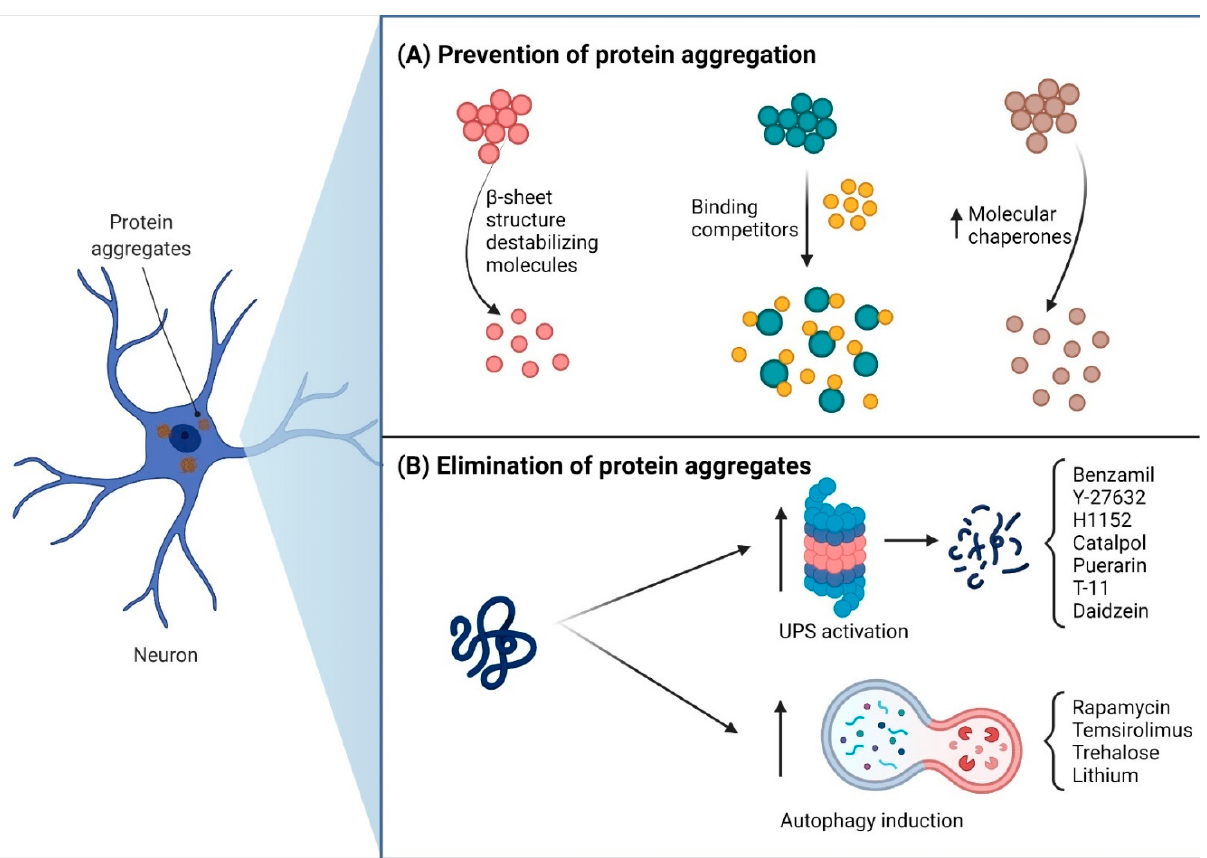
Figure 2. Pharmacological therapeutic perspectives for SCA. ( A ) Three different strategies to prevent mutant protein aggregation. ( B ) Elimination of protein aggregates by the enhancement of ubiquitin–proteasome system (UPS) or autophagy with different drugs.